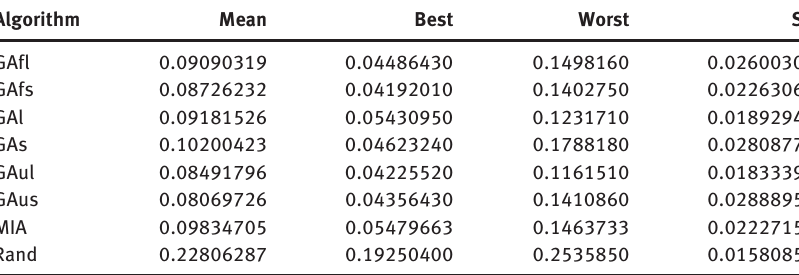
Table 9. Length 17 64 PSK